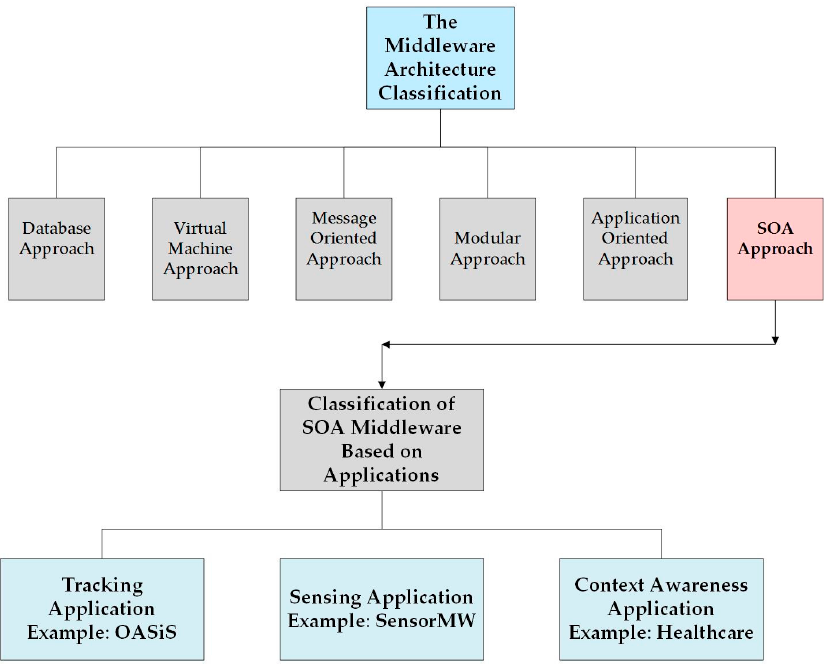
Figure 4. The Classification of Middleware Architectures for WSNs.